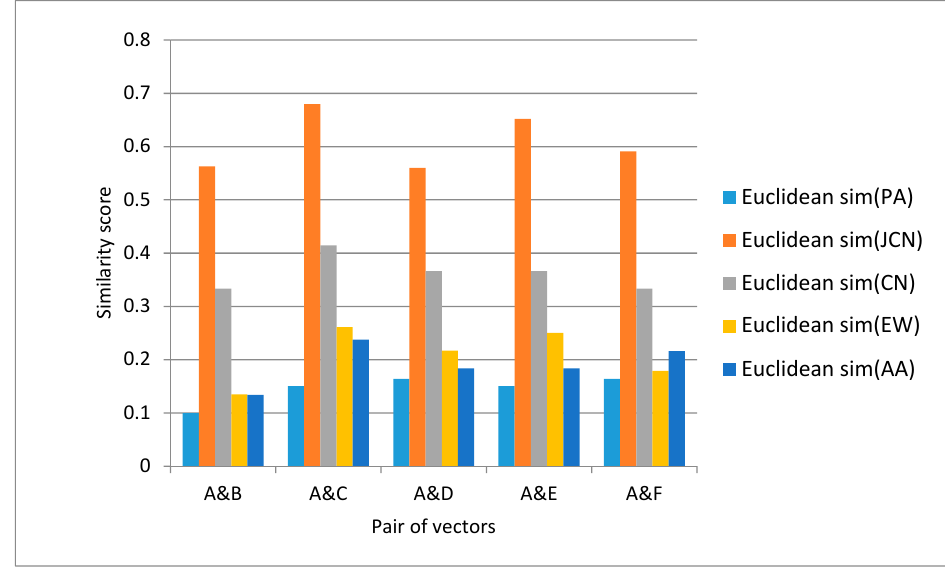
Table 3. Most similar node for node A.